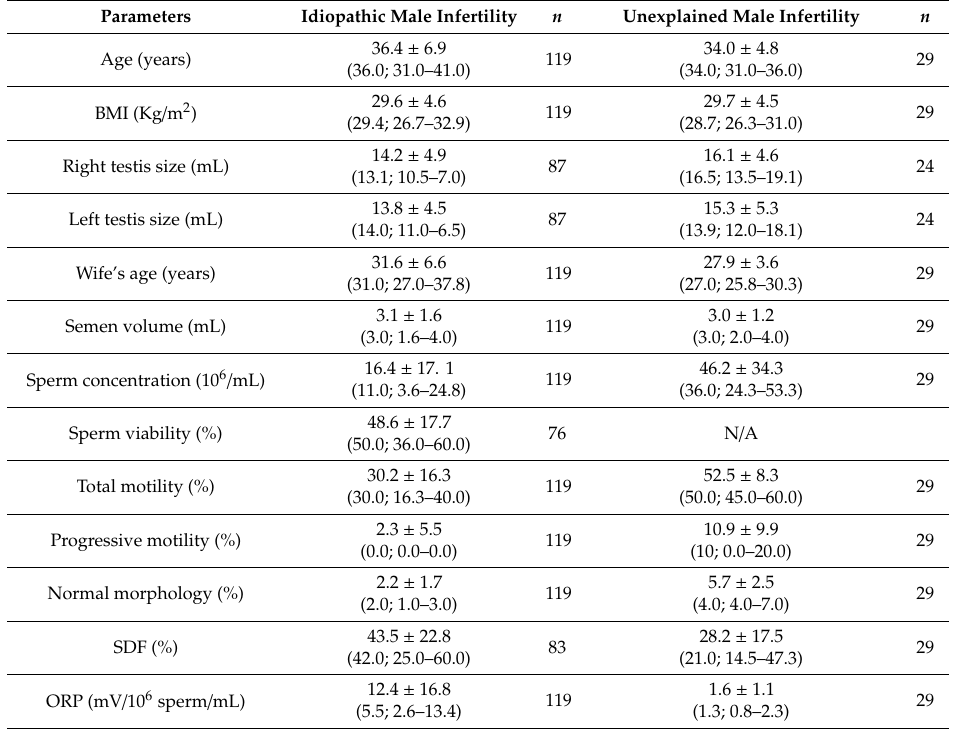
Table 1. Baseline summary statistics of idiopathic (at least one abnormal sperm parameter) and unexplained (normozoospermic) male infertility